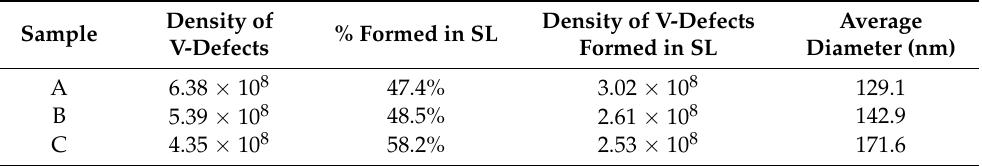
Table 1. Statistics on v-pit distribution for 3 LEDs with different SL